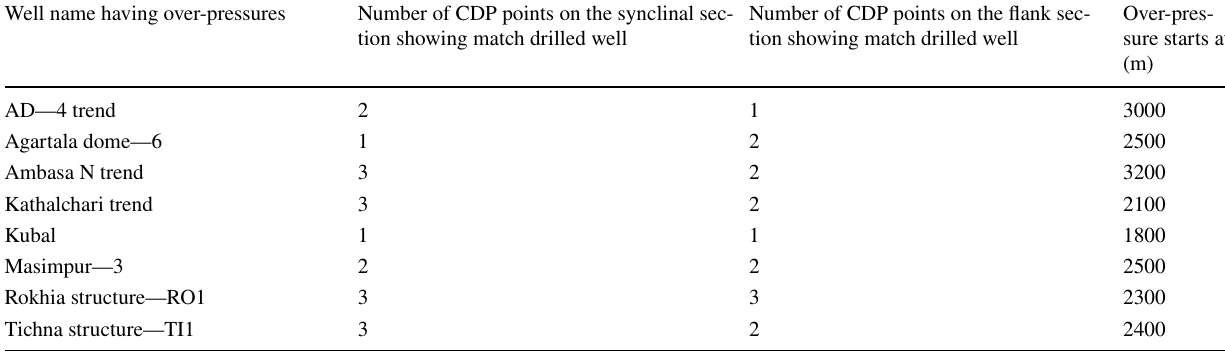
Table 1 Predicted pore pressures match with measured pore pressures from offset wells (Reproduced with permission from Brahma 2013) Well name having over-pressures Number of CDP points on the synclinal sec- Number of CDP points on the flank sec- Over-pres- tion showing match drilled well tion showing match drilled well sure starts at